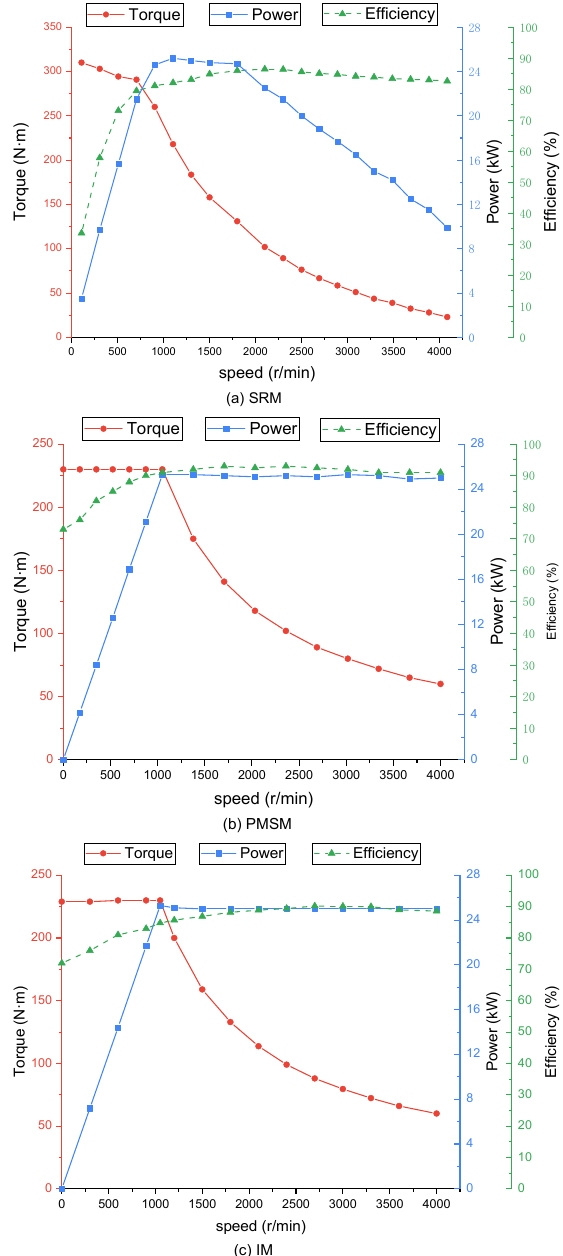
Figure 3. Characteristics of three walking motors. ( a ) Characteristics of the switched reluctance motor (SRM). ( b ) Characteristics of the permanent magnet synchronous motor (PMSM). ( c ) Characteristics of the induction motor